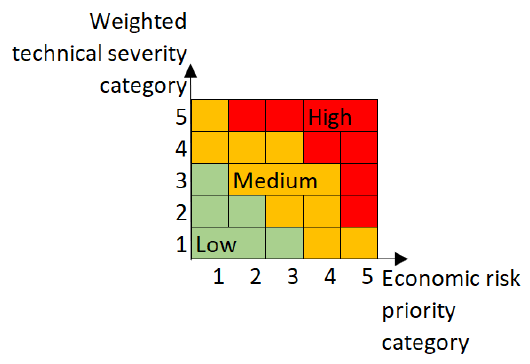
Figure 5. Relevance matrix.